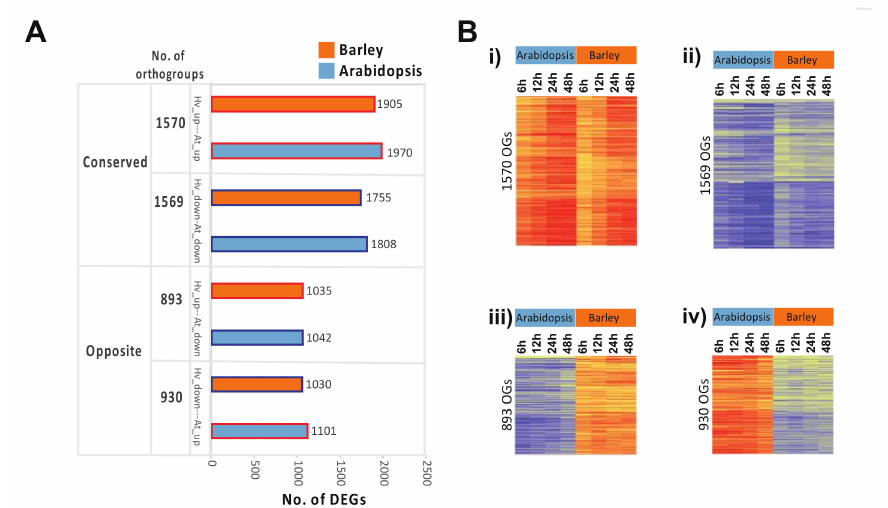
Figure 4. Expression of genes in orthogroups. ( A ) The number of DEGs in barley and Arabidopsis that were orthologous and showed conserved or opposite responses. Conserved was defined as orthogroups containing genes that were only up / downregulated over the time course at one or more time points in both species, while opposite orthogroups were identified as those in which opposite contrasting responses were observed between both species. Both groups exclude any orthogroups in which genes were both up- and downregulated over the time course and in which orthologues within the same orthogroup showed contrasting opposite responses for each species. ( B ) Heatmaps showing the conserved and oppositely responsive genes in barley and Arabidopsis, (i) genes in orthogroups that are conserved with an increase in transcript abundance in Arabidopsis and barley, and (ii) conserved with a decrease in transcript abundance in Arabidopsis and barley, (iii) genes in orthogroups that displayed a decrease in transcript abundance in Arabidopsis but an increase in barley, and (iv) genes in orthogroups that displayed an increase in transcript abundance in Arabidopsis but a decrease in